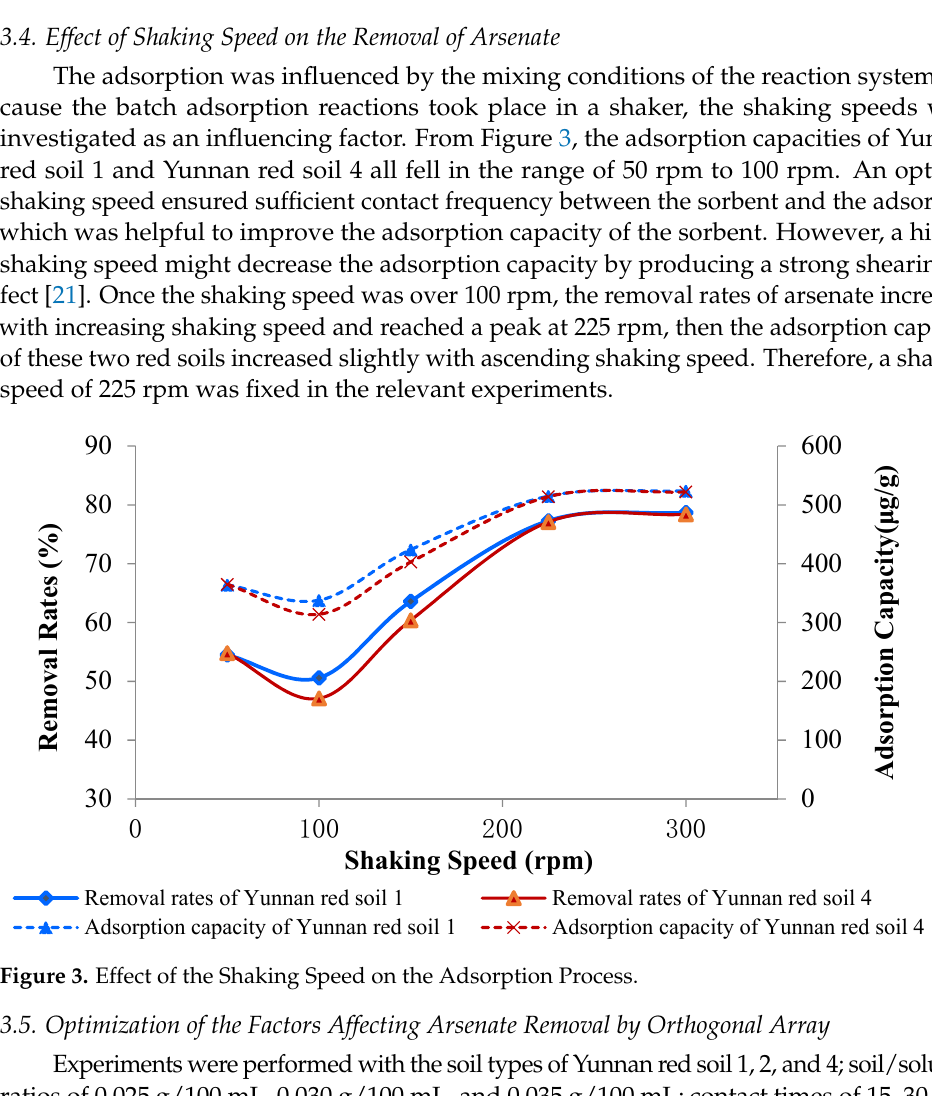
Table 3. The L 9 (3 4 ) Orthogonal Array Experimental Design and Arsenate Removal Efficiency As Response.